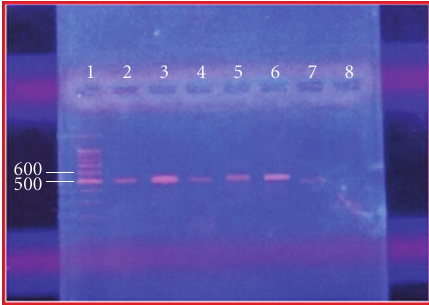
Figure 3: PCR products for 16SrRNA-based primers gave band on agarose gel corresponding to a 500 base pair product when compared to the molecular ladder. Lane 1, molecular ladder (1500– 100)bp, lane (2–6) bands of PCR products for H. pylori with 16SrRNA.